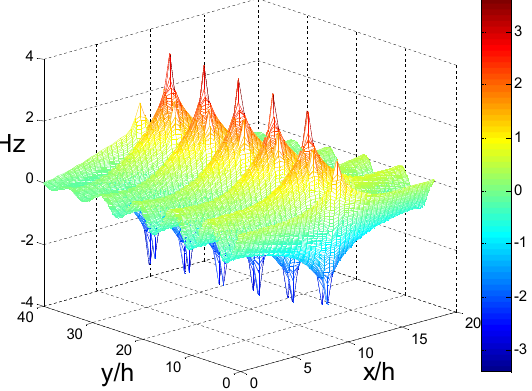
Figure 9. Near field propagation distribution representing the wavelength of 292 nm.